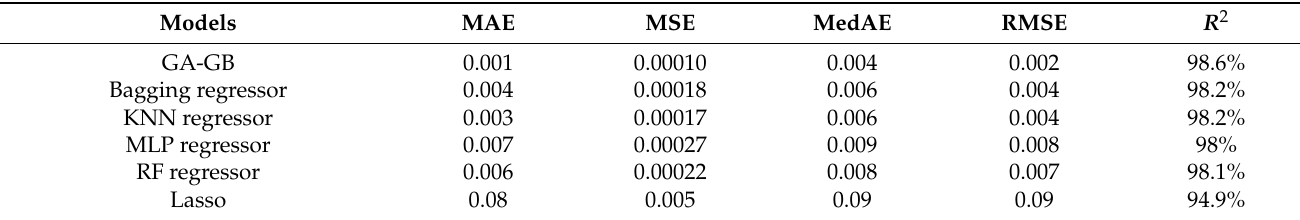
Table 12. Performance of the regression models for oil demand dataset.